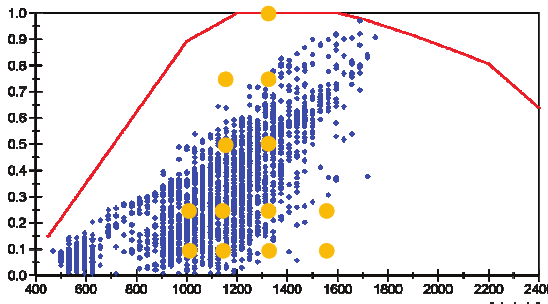
Fig. 3. Normalized torque as a function of crankshaft rotational speed and a series of measurement points The following parameters were registered: